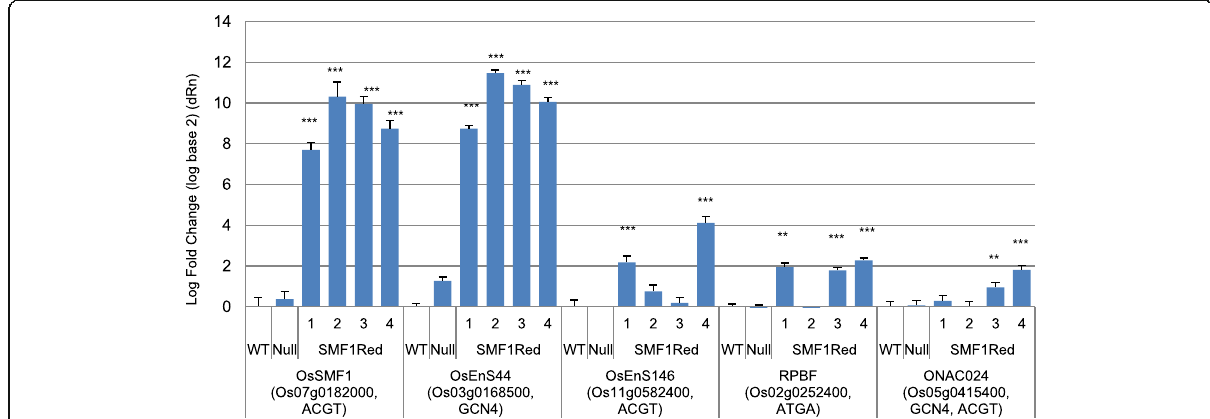
Fig. 5 Expression of four genes in wild-type and OsSMF1-transformed rice, as determined by real-time PCR. The expression levels of genes in W si:SMF1Red calli after normalization to Tubulin was compared with those in wild-type calli. The results shown are the mean±SD; n =3 ( *** P <0.001; ** P <0.01; and * P <0.05 compared with wild